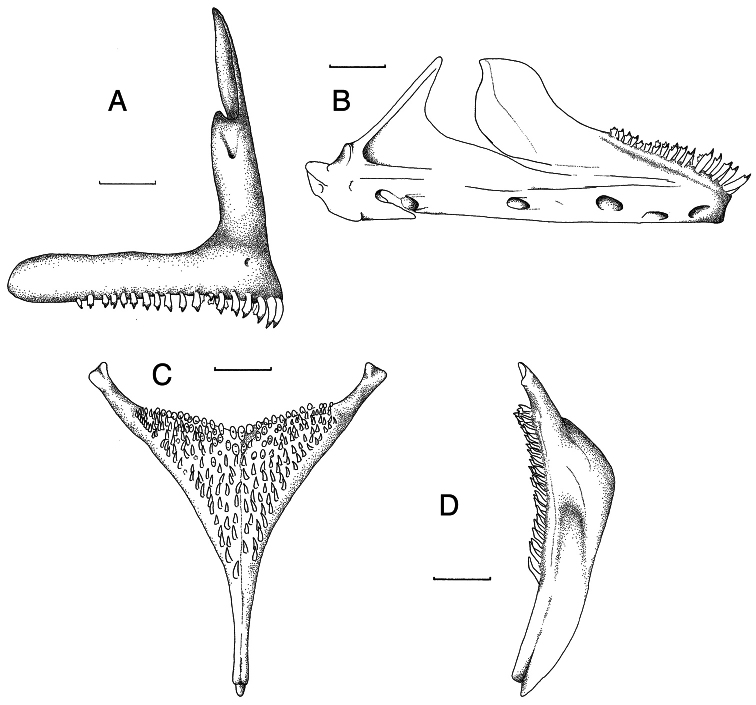
Skeletal elements of Haplochromis goldschmidti sp. n. A Right premaxilla, lateral view (RMNH.PISC.83695) B Right lower jaw, lateral view (RMNH.PISC.83695) C Lower pharyngeal element, dorsal view (RMNH.PISC.83701) D Lower pharyngeal element, lateral view (RMNH.PISC.83701). Scale bars equal 1 mm. Drawn by I. Westbroek.